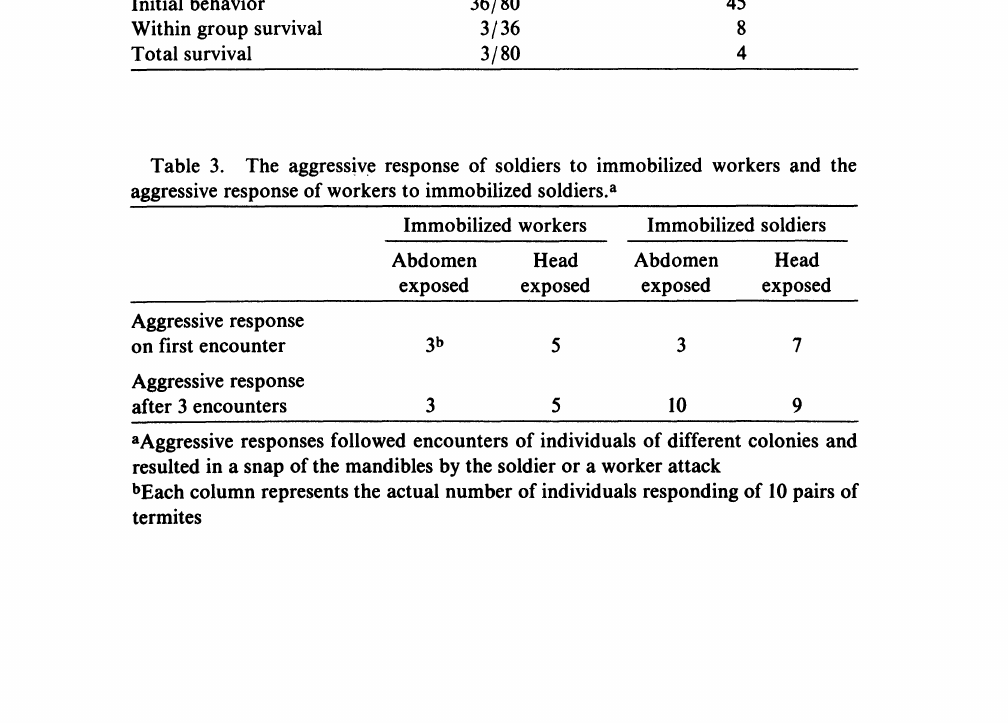
Table 2. Comparison of worker behavior and survival during all intercolony pairings of soldiers and workers.